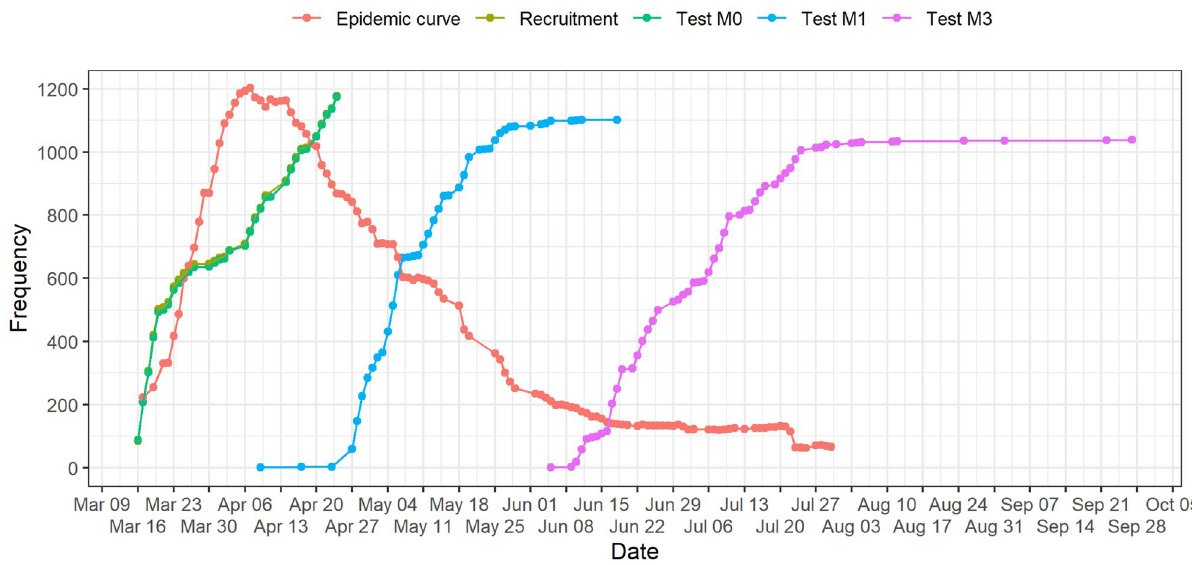
Figure 2. Dates of inclusion (recruitment) and serology tests according to the epidemic curve (in patients with documented COVID-19 in AP-HP hospital network).